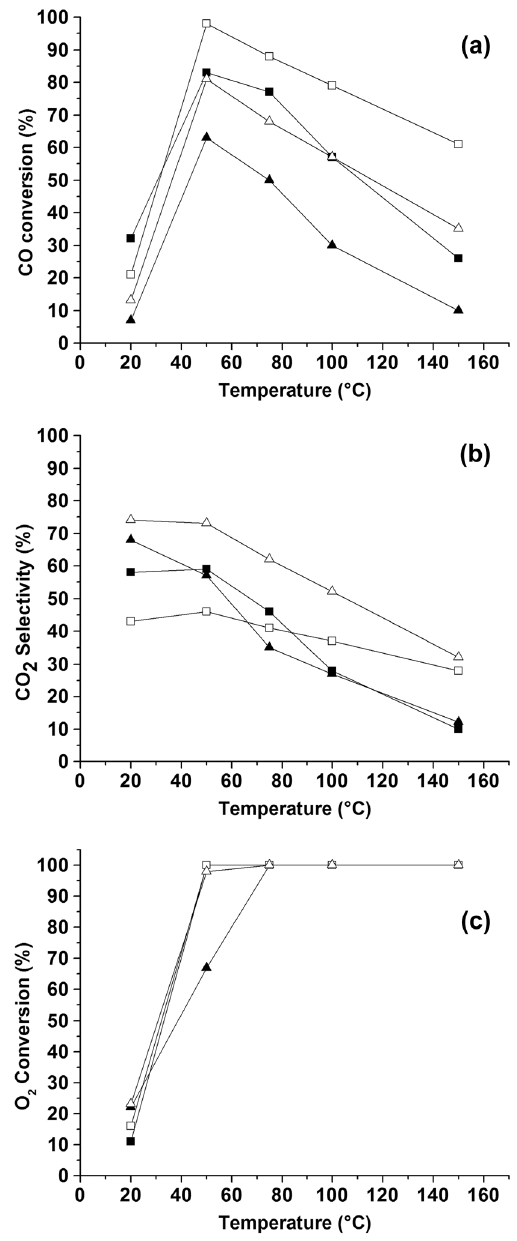
Fig. 4 Catalytic performance of Pt/CeO sion, ( b ) CO 2 selectivity, and ( c ) O 2 conversion (filled square Pt1/